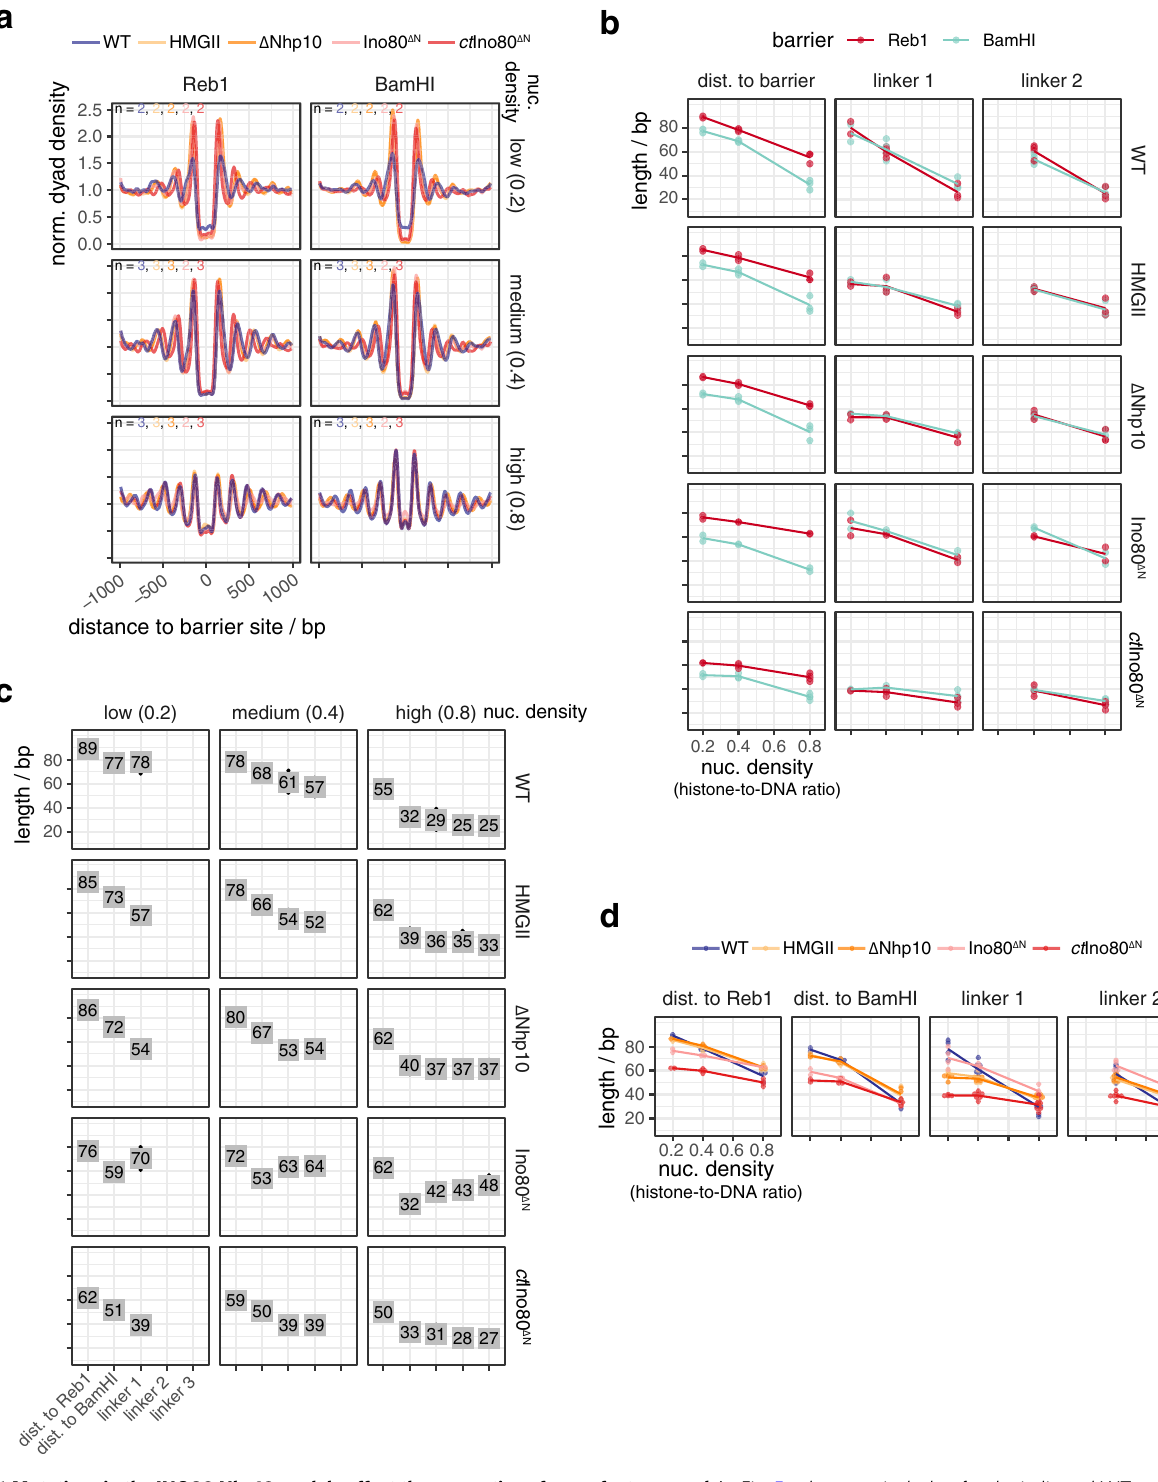
nucleosome arrays in absolute terms? We fi nd that ATP- dependent remodelers with spacing activity from the ISWI, CHD, and INO80 families do not only equalize linker lengths but bear rulers for setting distances between two adjacent nucleo- somes and between nucleosomes and other alignment points. NATURE COMMUNICATIONS| (2021) 12:3232